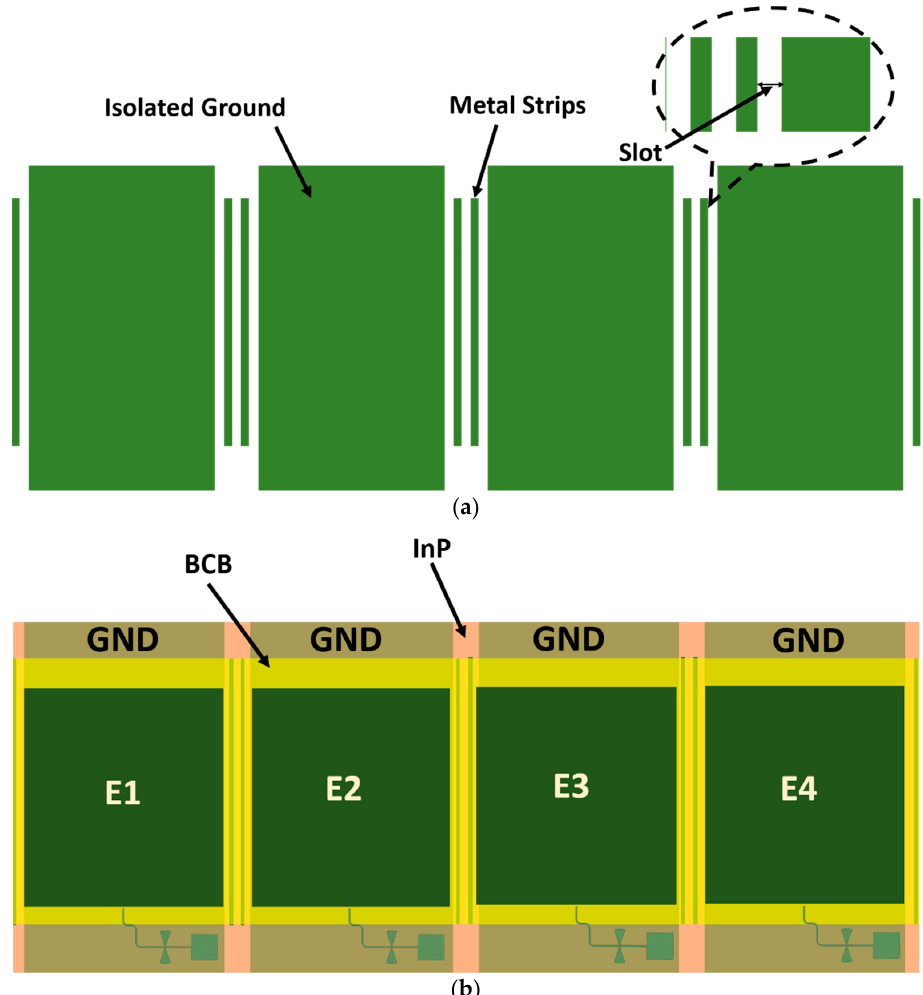
Figure 8. ( a ) Modified defected ground plane, ( b ) modified layout of 1 × 4 array.